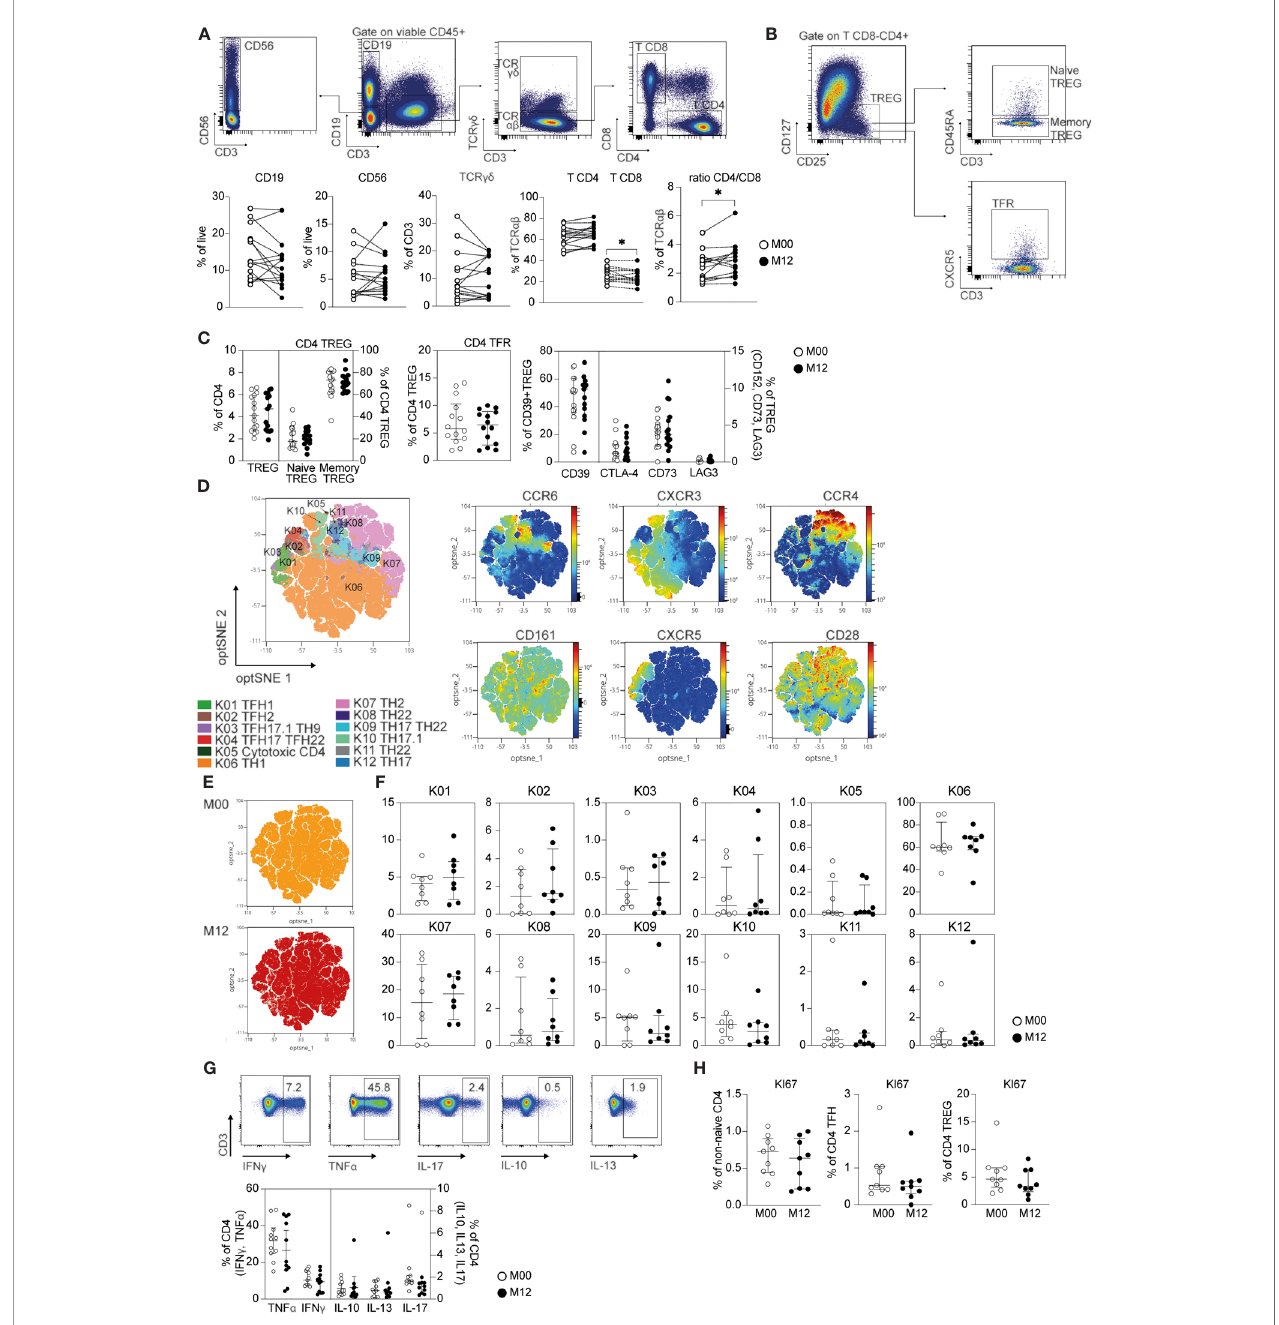
FIGURE 1 | CD4 and CD8 T cell changes in teri fl unomide-treated patients with RRMS. (A) Main immune cell populations in patients with RRMS at baseline (white) or 12 months post teri fl unomide treatment (black; n=15). The gating strategy is shown after exclusion of dead cells, doublets and CD45 - cells (B cells, CD19 + CD3 - CD56 - ; NK, CD56 + CD19 - CD3 - ; gd T cells, CD19 - CD56 - CD3 + TCR gd + ; ab CD4 T cells, CD19 - CD56 - CD3 + TCR gd - CD8 - CD4 + ; ab CD8 T cells, CD19 - CD56 - CD3 + TCR gd - CD8 + CD4 - ). (B, C) Frequency of CD4 T REG andCD4 T REG subsets inpatients with RRMS at baseline (white) or 12 months post-teri fl unomide treatment (black; n=15). The gating strategyis shownafterinitialgatingonCD19 - CD56 - CD3 + TCR gd - CD8 - CD4 + (T REGS ,CD25 high CD127 low ;naïveT REGS ,CD25 high CD127 low CD45RA + ;memoryT REGS ,CD25 high CD127 low CD45RA - ; T FRS , CD25 high CD127 low CXCR5 + ). (D) optSNE projection ofnon-naïve ab CD4 Tcell clusters identi fi edbyFlowSOM metaclustering. optSNE projectionsoftheexpressionofthe indicated proteins are shown. (E) Global optSNE projection of non-naïve ab CD4 T cells for all participants pooled, with non-naïve ab CD4 T cells of patients with RRMS at M00 and M12 post-teri fl unomide treatment concatenated and overlaid. (F) Percentage of non-naïve ab CD4 T cells from each timepoint in each FlowSOM cluster. (G) T H 1 cell (IFN g , TNF a ), T H 2 cell (IL-4, IL-13), T REG (Il-10) and T H 17 cell (IL-17) cytokine production by CD4 T cells in patients with RRMS at M00 (white) and M12 post-teri fl unomide treatment (black) after polyclonal restimulation. (H) KI67 expression in non-naïve ab CD4 T cells, T FH cells (non-naïve ab CD4 CXCR5 + ) and CD4 T REGS . (A, C, E – H) Each dot represents a unique patient, and the median and interquartile ranges (IQRs) are shown. Signi fi cance was determined by unpaired Mann-Whitney U or paired Wilcoxon test. *p <